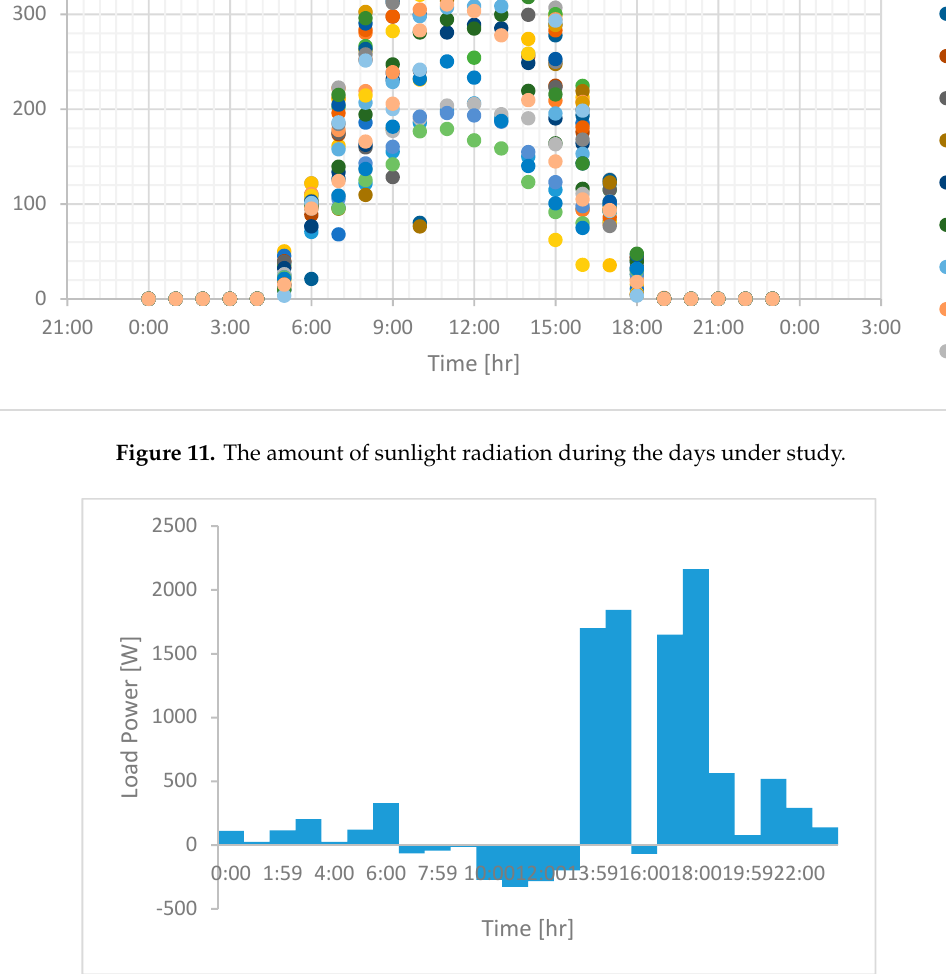
Figure 13. All cluster centers of mass data. 5.5. Fraud Detection The anomalies of power distribution networks fall into five categories: 1.